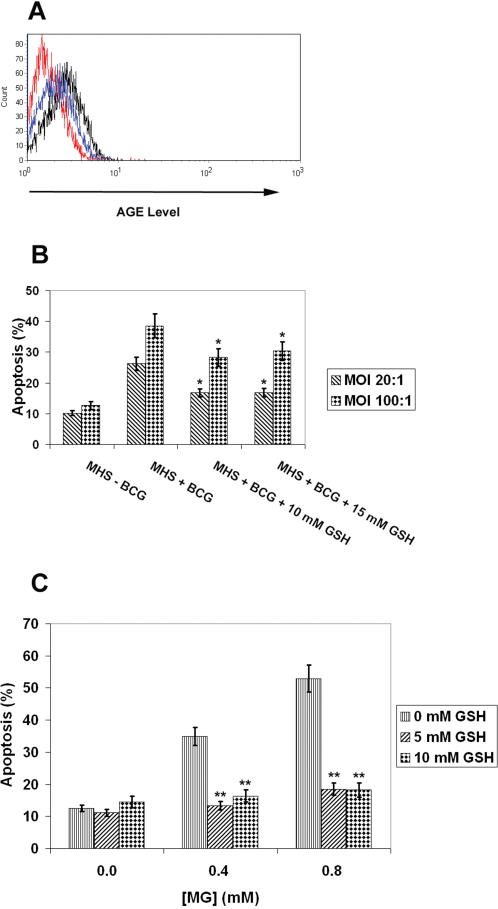
GSH Reverses Apoptotic Effects of MG/AGE on Macrophages.(A) Macrophages were pretreated with GSH and infected with mycobacteria for 1 day.As a positive control, macrophages were infected with mycobacteria without pretreatment with GSH.AGE levels were determined using a FACS instrument.Red line: negative control (without infection), black line: positive control, blue line: pretreatment with GSH. The augmentation of AGE levels was reduced during mycobacterial infection when macrophages were pretreated with GSH. (B) Pretreatment of macrophages with GSH reduced the proportion of apoptotic cells during mycobacterial infection.Error bars represent±SD.Statistical significance was determined by Student's t test; *, P<0.05 for MH-S cells pretreated with GSH and infected with mycobacteria versus MH-S cells infected with mycobacteria without pre-treatment with GSH.(C) Pretreatment of macrophages with GSH reduced the proportion of apoptotic cells during MG treatment.Error bars represent±SD.Statistical significance was determined by Student's t test; **, P<0.001 for MH-S cells pretreated with GSH and treated with MG versus MH-S cells treated with MG without pretreatment with GSH.